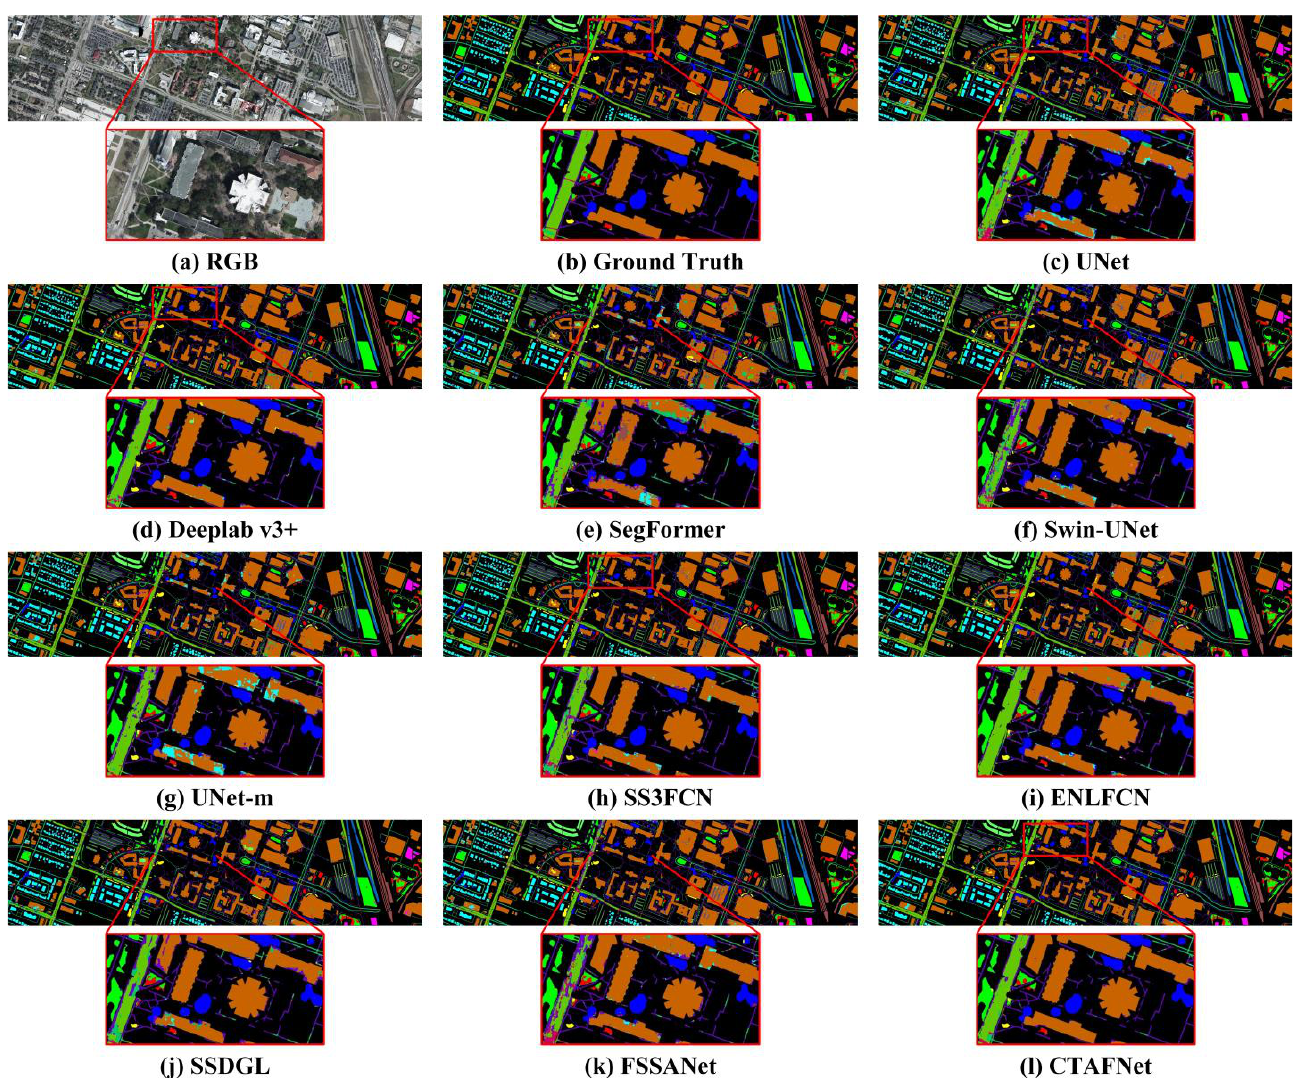
Figure 8. Visually comparison of different methods on the DFC2018 dataset. Table 6. Classification results for the DFC2018 test